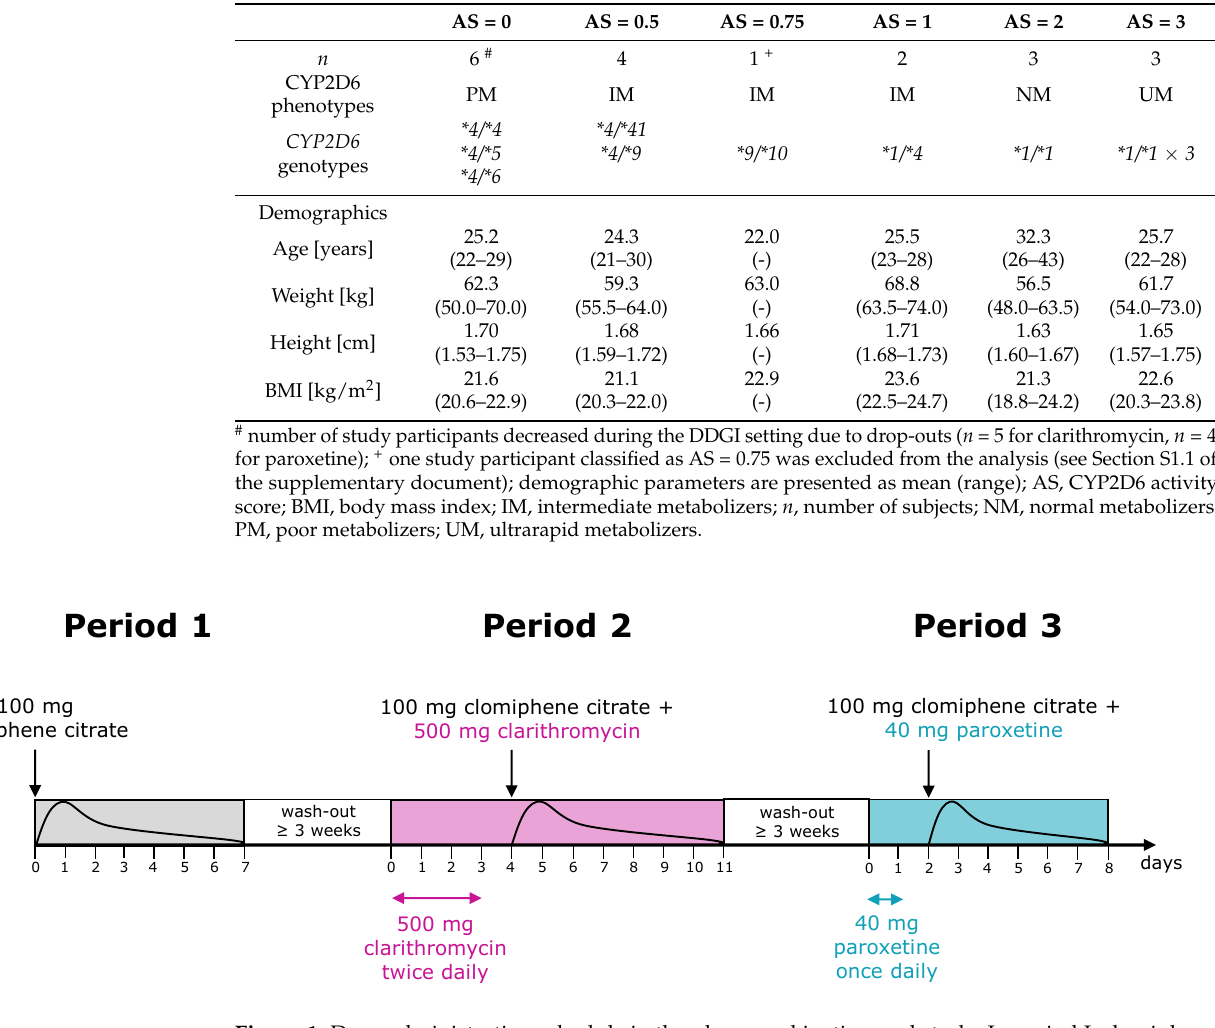
Figure 1. Drug administration schedule in the pharmacokinetic panel study. In period I, clomiphene citrate alone; in period II, combined with clarithromycin; and in period III, combined with paroxetine was